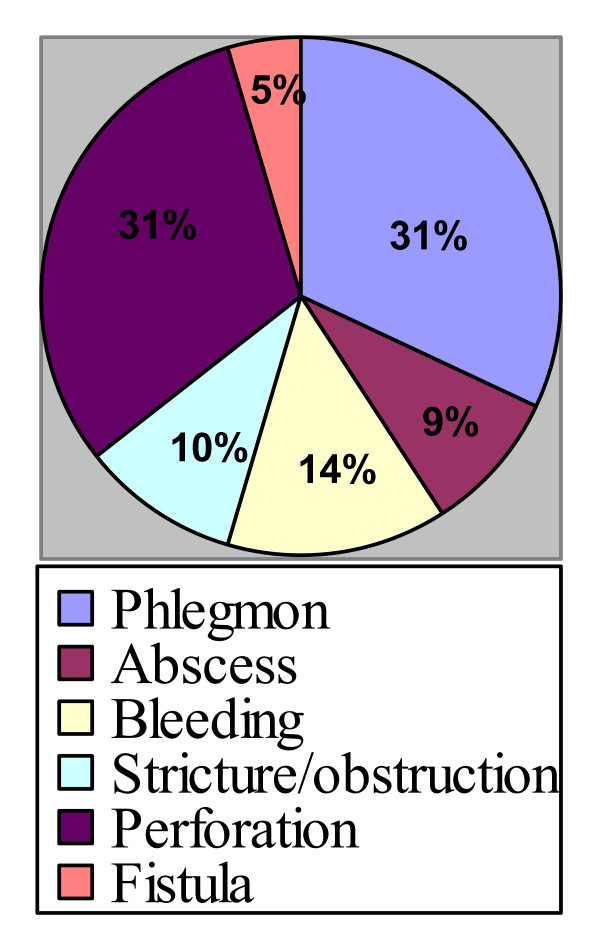
Presentation of complicated diverticular disease.